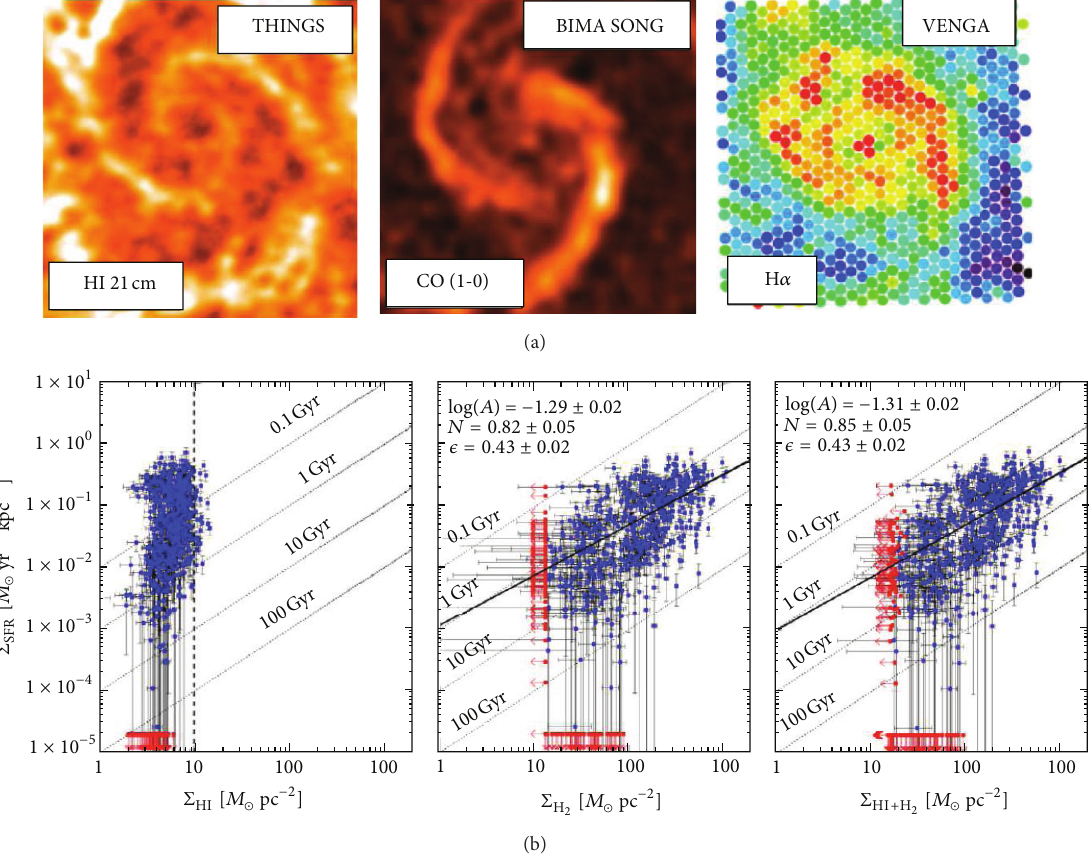
Figure 4: (a) Maps of the HI 21 cm, CO (1-0), and H 𝛼 emission (from left to right) from the THINGS [83], BIMA-SONG [84], and VENGA [29] surveys used in Blanc et al. [17] to study the spatially resolved SFL in the central 4kpc of NGC 5194. (b) The HI, H2, and total SFL as measured by Blanc et al. [17]. Each blue dot corresponds to a single Mitchell Spectrograph fiber. Upper limits are shown in red and dotted lines show lines of constant depletion time. The best-fit relations are also shown as well as the corresponding best-fit parameters.